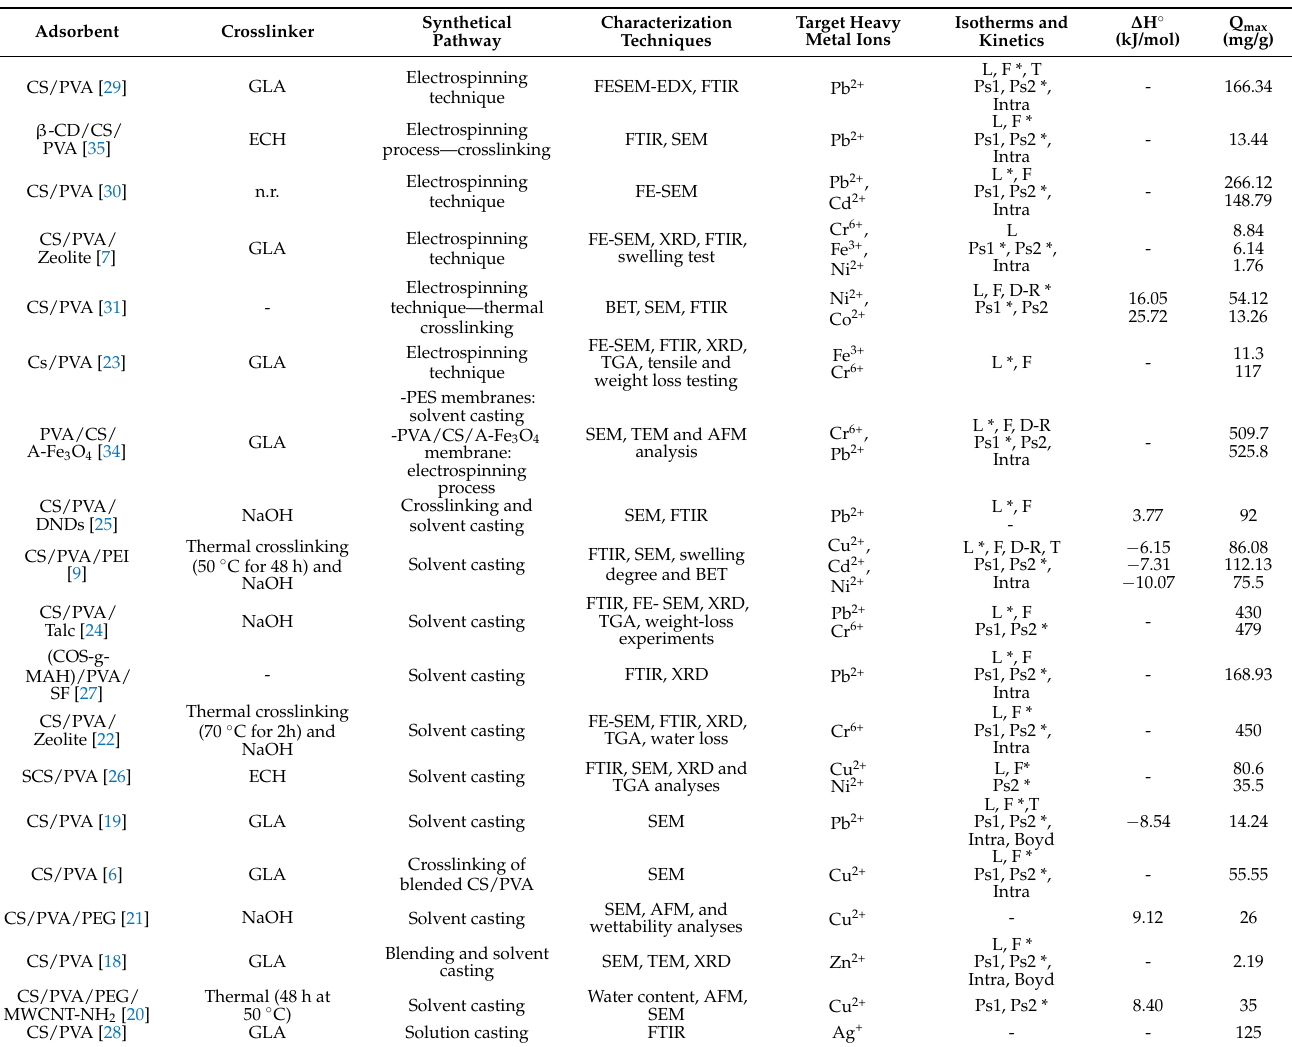
Table 2. Chitosan/poly(vinyl alcohol)-based membranes for heavy metal ions removal. Adsorbent Synthetical Pathway Characterization Techniques Target Heavy Metal